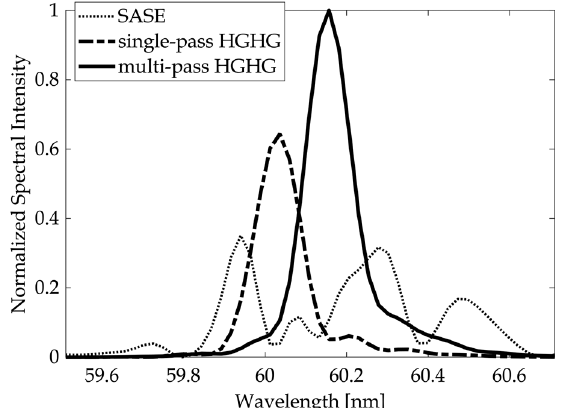
FIG. 10. Output 60 nm spectra for the three cases with the same lattice and input electron beam parameters. For the HGHG simulations, this is the 5th harmonic of 300 nm seed laser. For the multipass HGHG, we show the results for the 65th pass. The domain shows a wavelength range of (cid:2) 3 ρ around the central wavelength of the single-pass HGHG. For the SASE simulation, the amplifier is extended to reach saturation.